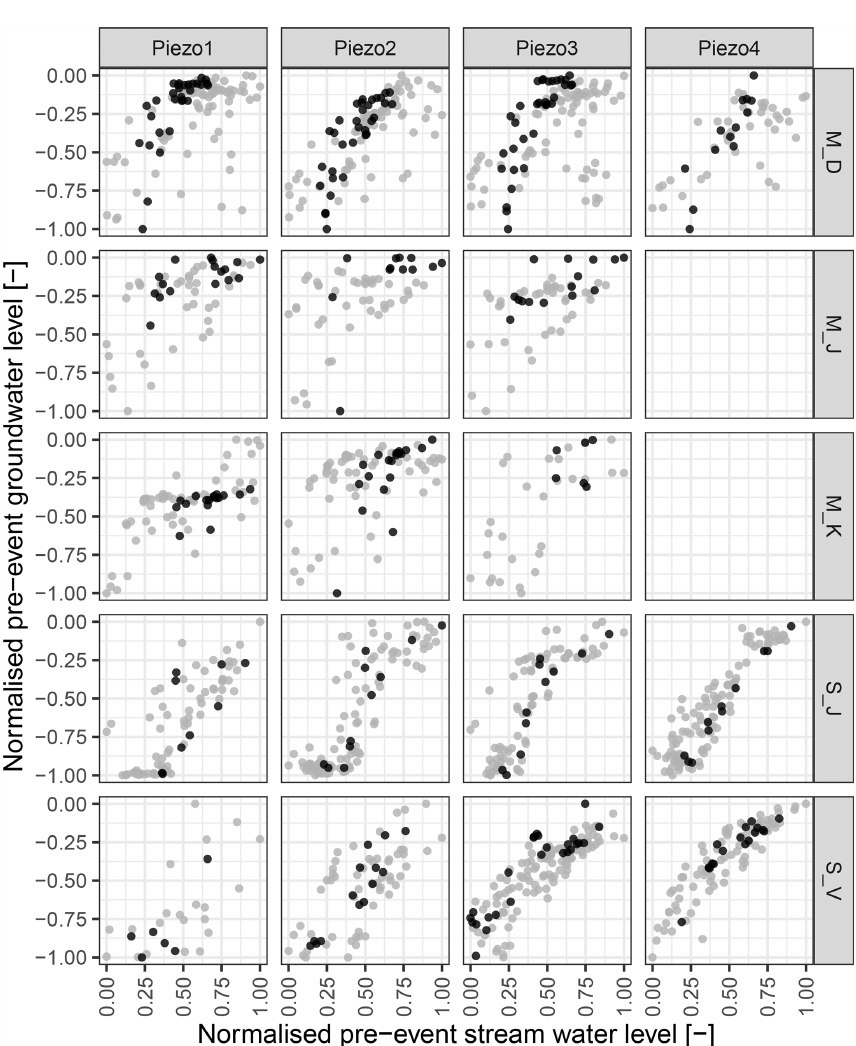
Figure B1. Normalised stream and groundwater levels. Black events are from 2015, while grey events are from all other years. (Replotting of Fig. 8 to visualize the effect of a reduced (1-year) observation